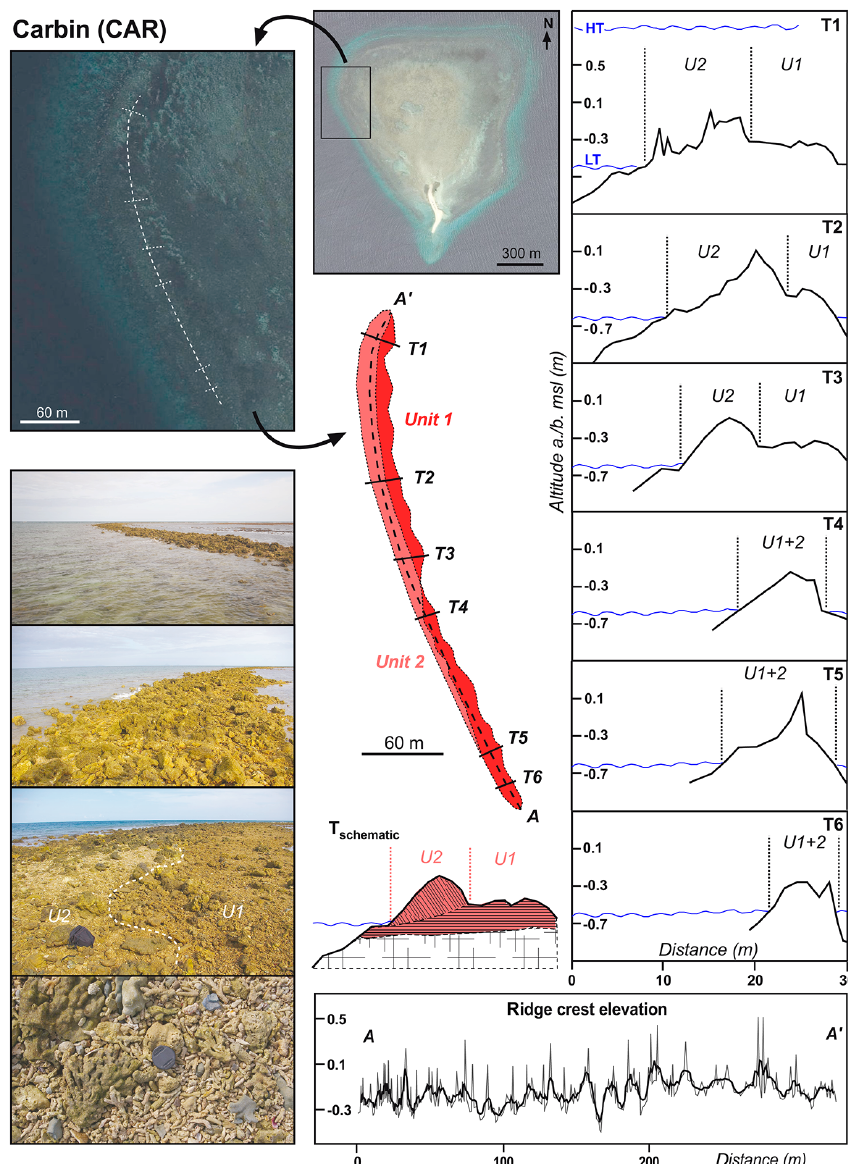
Figure 9. Carbin Reef (CAR) study site with typhoon-generated coral-rubble ridge. The ridge at the western edge of the reef platform shows no clear trend of crest elevation, but significant differences in width and shape between six coast-perpendicular transects (T1–T6). In the northern part of the ridge, flat and up to 30m wide lobes composed of algae-covered, greyish coral fragments form the basal unit of the ridge (U1). Unit 1 is topped by steeper lobes with a significant percentage of freshly broken coral fragments that occur along the whole ridge section but reach widths of only 10m (U2). The presence of two morphostratigraphical units might be due to either changing wind directions during formation entirely by Haiyan or the impact of successive storms where Haiyan only deposited the uppermost